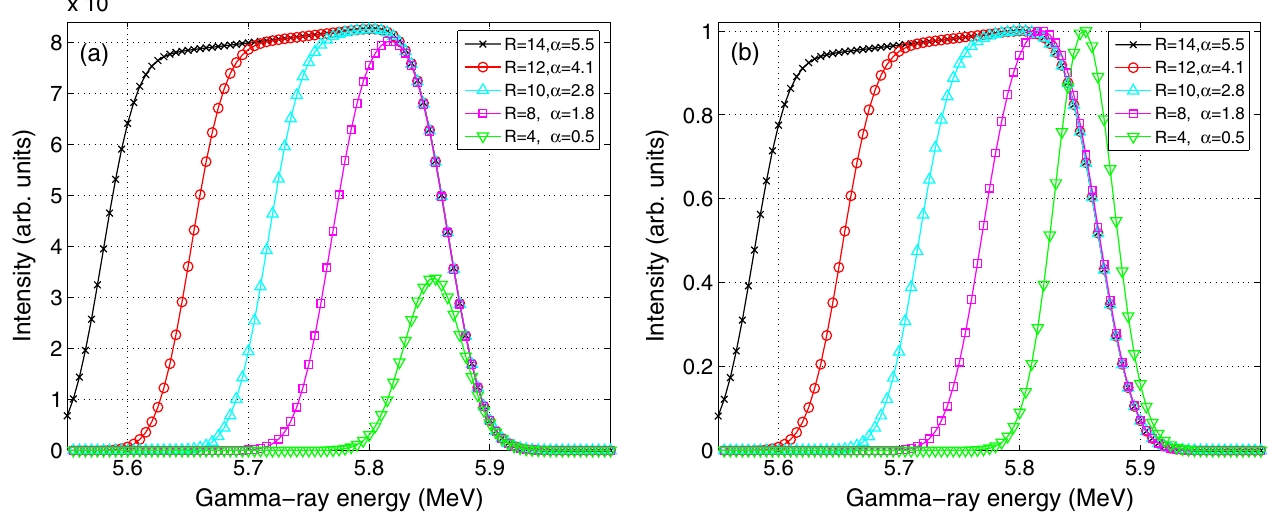
FIG. 3. (Color) Calculated energy spectra of gamma beams produced by Compton scattering of a 800 nm laser beam with a 500 MeV electron beam for different radii of the collimation aperture. The aperture is placed 60 m downstream from the collision point, and its radius R is varied from 14 to 4 mm. (cid:8) is defined in Eq. (17). The horizontal emittance and energy spread of the electron beam are fixed at 0.05 nm rad and 2 (cid:1) 10 (cid:2) 3 , respectively. (a) Spectra are normalized to the intensities of incident electron and laser beams. (b) Spectra are scaled to their respective peak